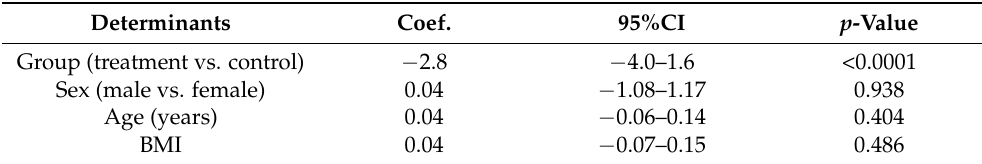
Table 4. Analysis of the determinants of the difference between ODI T1 and ODI T0 in a multivariate linear regression model. Coef. p -Value Group (treatment vs. control)